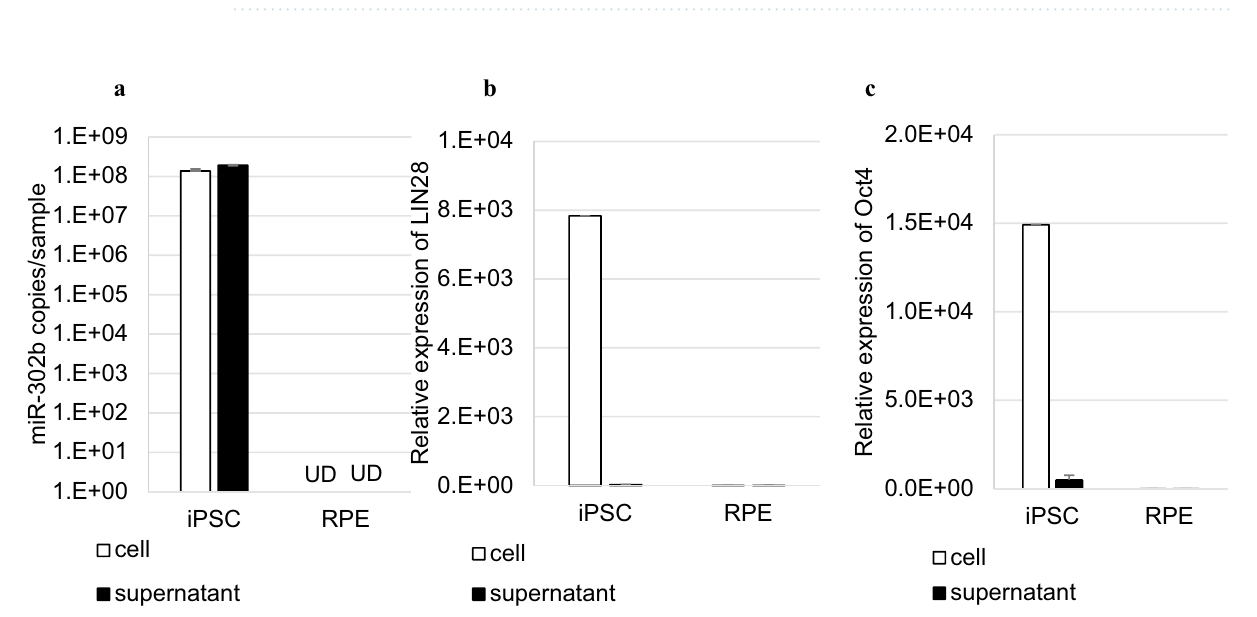
Figure 3. miRNA was abundantly secreted into the culture supernatant. The expression level of ( a ) miR-302b, ( b ) LIN28 , and ( c ) Oct4 in 10 5 iPSCs and 10 5 RPE cells and in 2 mL of their culture supernatants. For LIN28 and Oct4 , the vertical axis is the relative expression level as the expression level in RPE cells was 1. The level of miRNAs in the supernatant was corrected by multiplying the detected value with 20, because only 100 μL in 2 mL of the culture supernatants was used as a sample. As the cells were extracted from whole cells, such a correction was not performed. UD: no miRNA detected; error bar = + 3SD